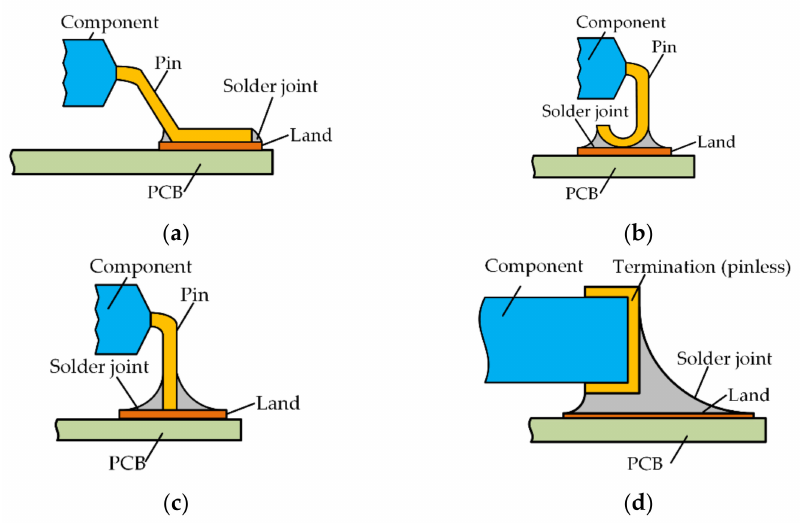
Figure 1. Pin forms of common SMT packages. ( a ) The gull-wing pin; ( b ) the I pin; ( c ) the J pin; ( d ) the pin-less form (using metal